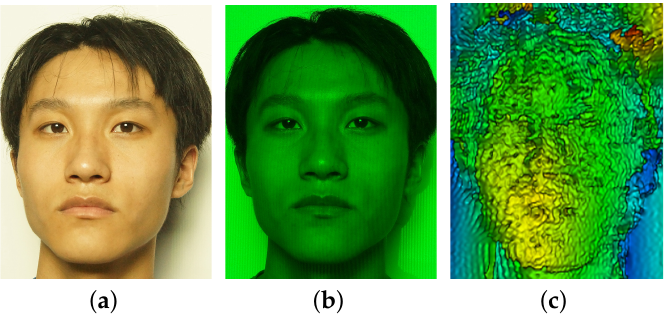
Figure 6. Measurement and reconstruction of a static human face at spatial frequency of 0.3 lp /mm and the background illuminance E = 200 Lux : ( a ) face image without optical filtering and polarizer; ( b ) face image with optical filtering and polarizer; and ( c ) reconstructed face using the measurement of (b).